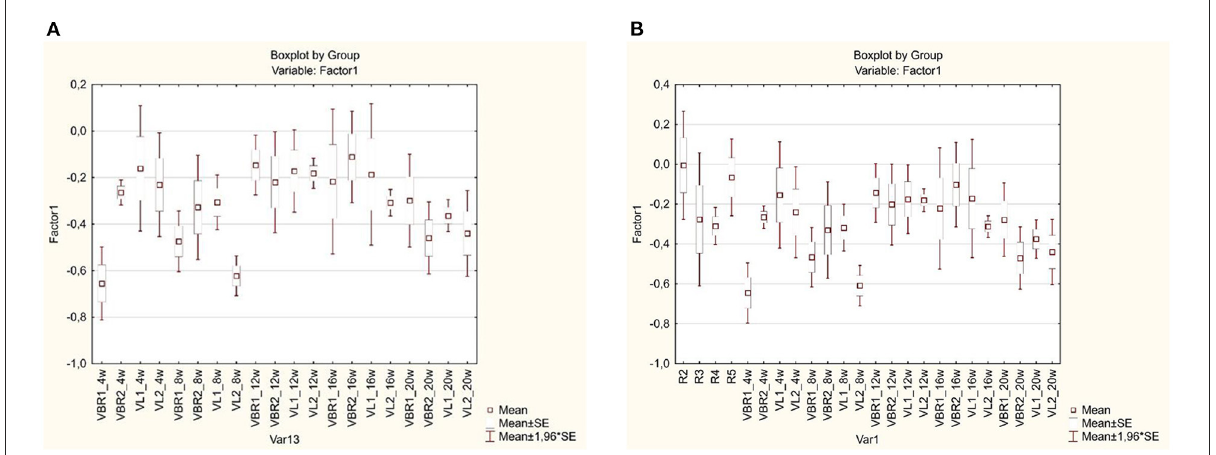
FIGURE4 (A) Box and whisker plot of carbon source utilization profiles for microbial communities present in different landraces and growth stages soil samples over time. (B) Box and whiskers plot constructed to determine the significant difference in the functional diversity of the bulk soil (control) and the various landraces at the different growth